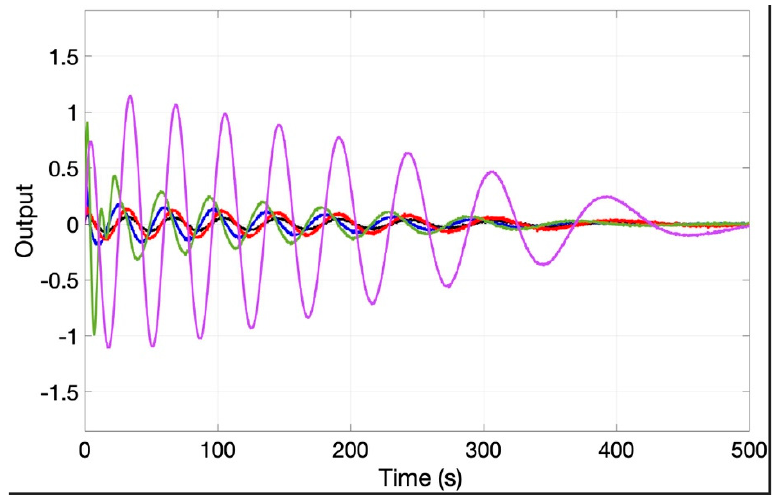
Figure 23. Disturbance rejection results for an integrative time delay process considering a swept sinusoidal disturbance signal with frequencies in [0.5 ω d , 2 ω d ] (black line–FO-PI deisgned using the RDR, blue line–FO-PID designed by Monje 2006, red line–FO-PID designed by Muresan 2022, green line–FO-PID designed by Valerio 2006, magenta line–FO-PI designed by Monje 2010). Table 3. Mean-squared errors for swept sine disturbance.